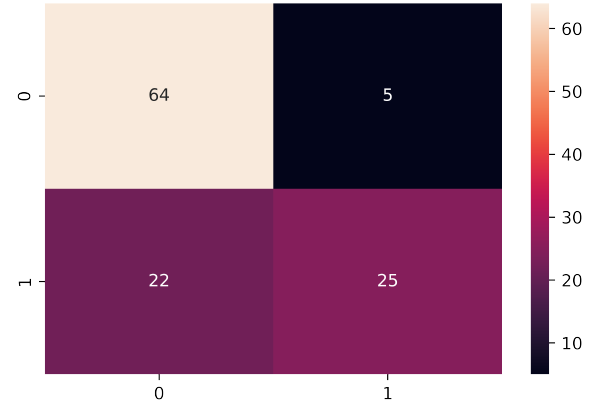
Figure 8. The confusion matrix obtained through unbalanced data